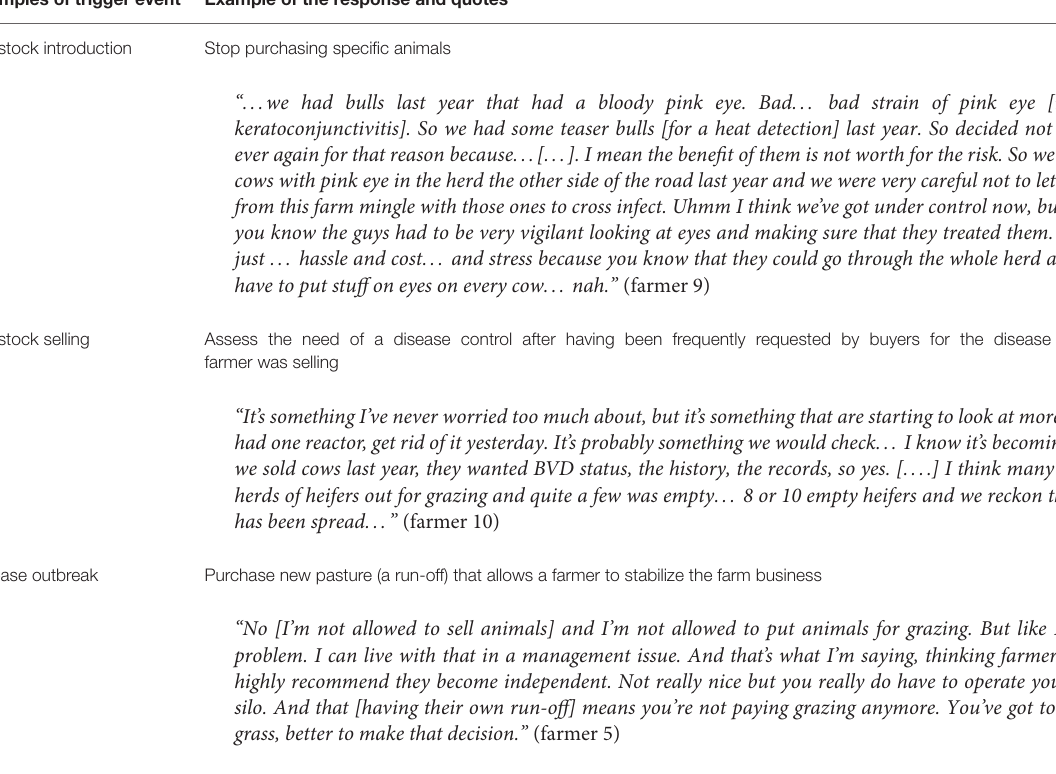
TABLE 2 | Examples of trigger events and accompanying responses made by farmers. Examples of trigger event Example of the response and